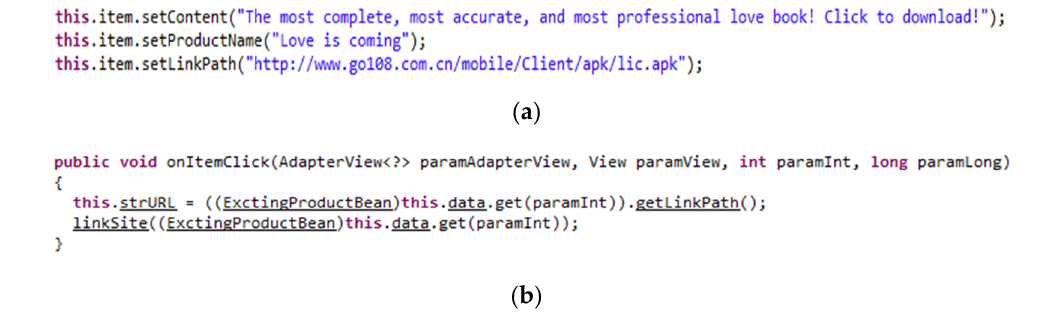
Figure 9. Implementation code for luring users to install junk software in the RogueSPPush sample: ( a ) placing ads for junk software to attract users; ( b ) downloading the corresponding package.